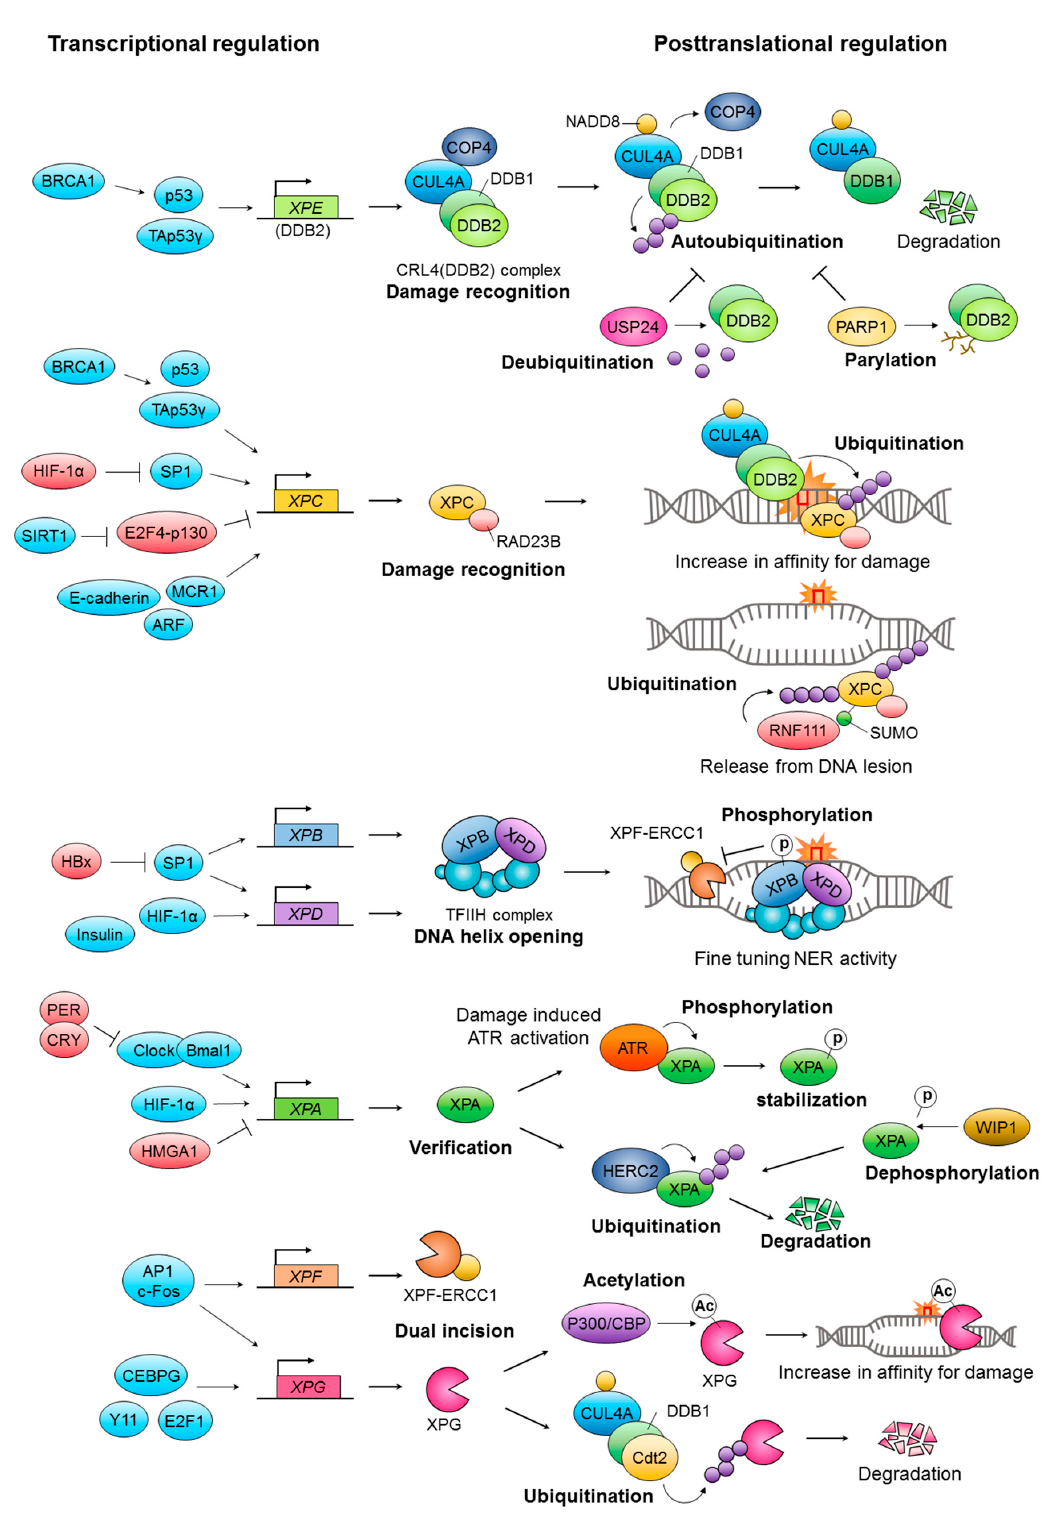
Figure 1. Schematic illustration for transcriptional and posttranslational modifications of core nucleotide excision repair (NER) factors. See text for detailed description.